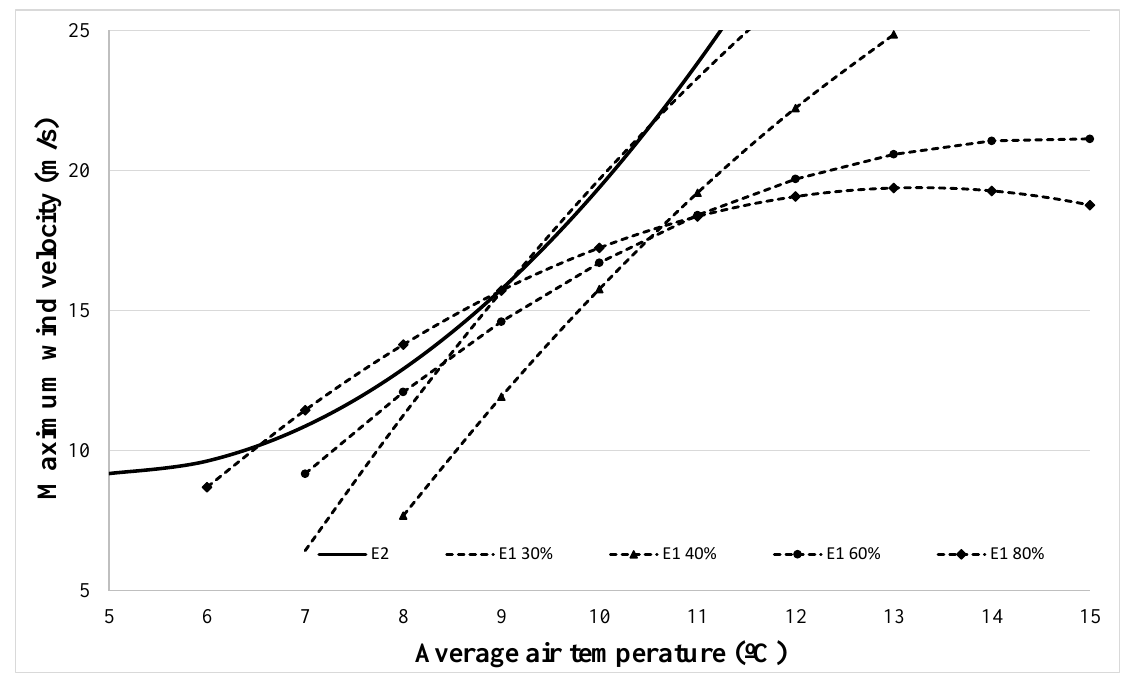
Figure 7. Maximum wind velocity for error 1 (E1) at different relative humidity and error 2 (E2).